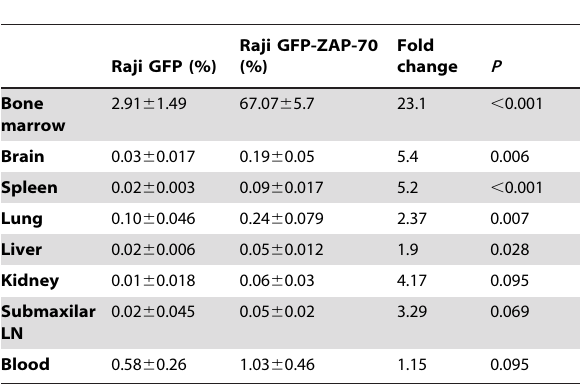
Table 1. Percentage of GFP-positive cells in the organs from mice injected with Raji GFP or Raji GFP-ZAP-70 cells as assessed by flow